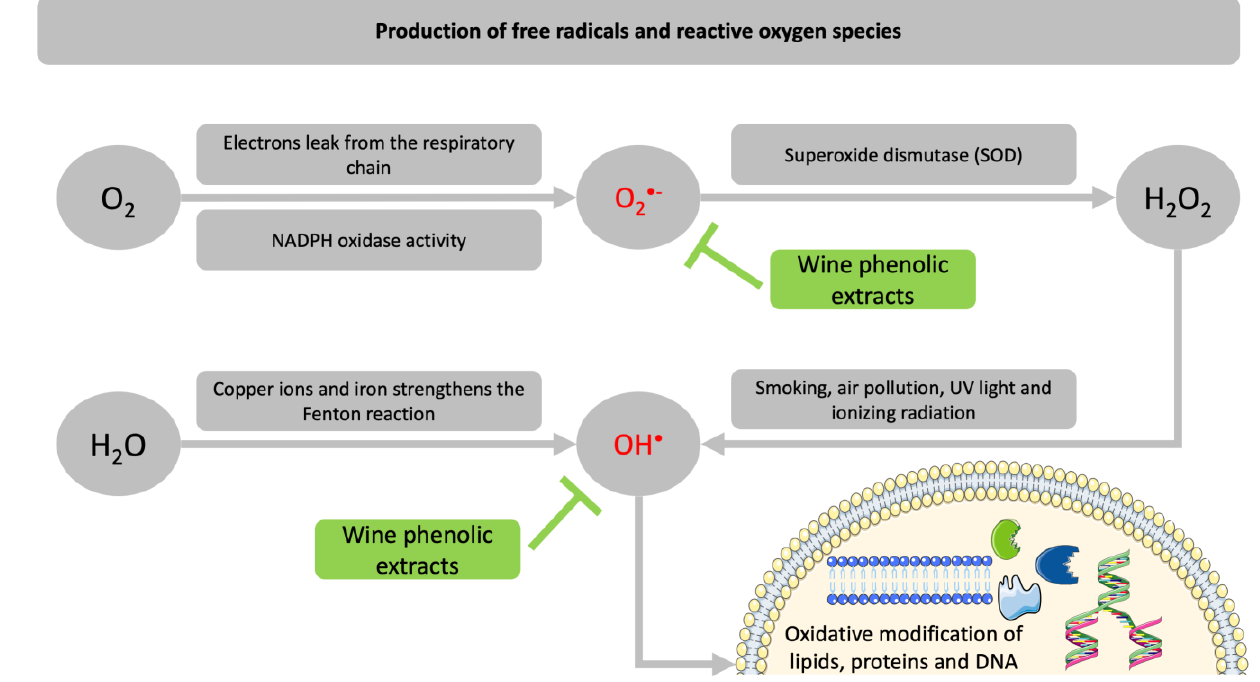
Figure 4. Production of free radicals and reactive oxygen species. O 2− : superoxide radical, OH: hydroxyl radical, H 2 O 2 : hydrogen peroxide.